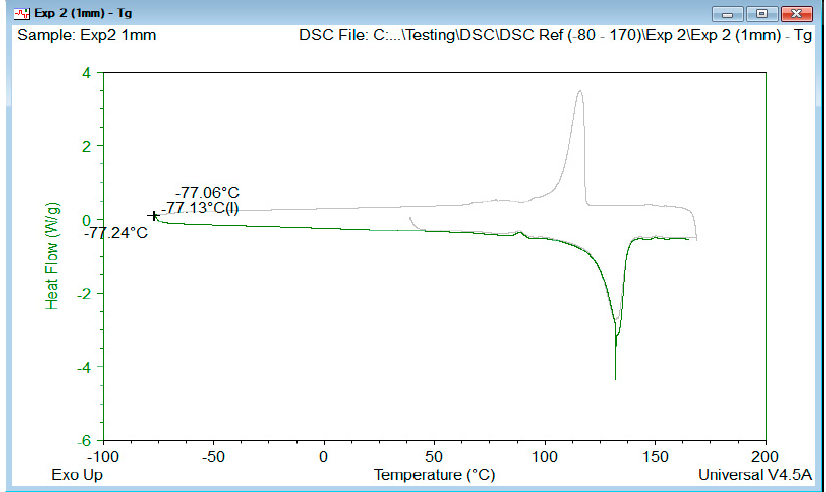
Figure A2. T g of HDPE after Experiment 1.